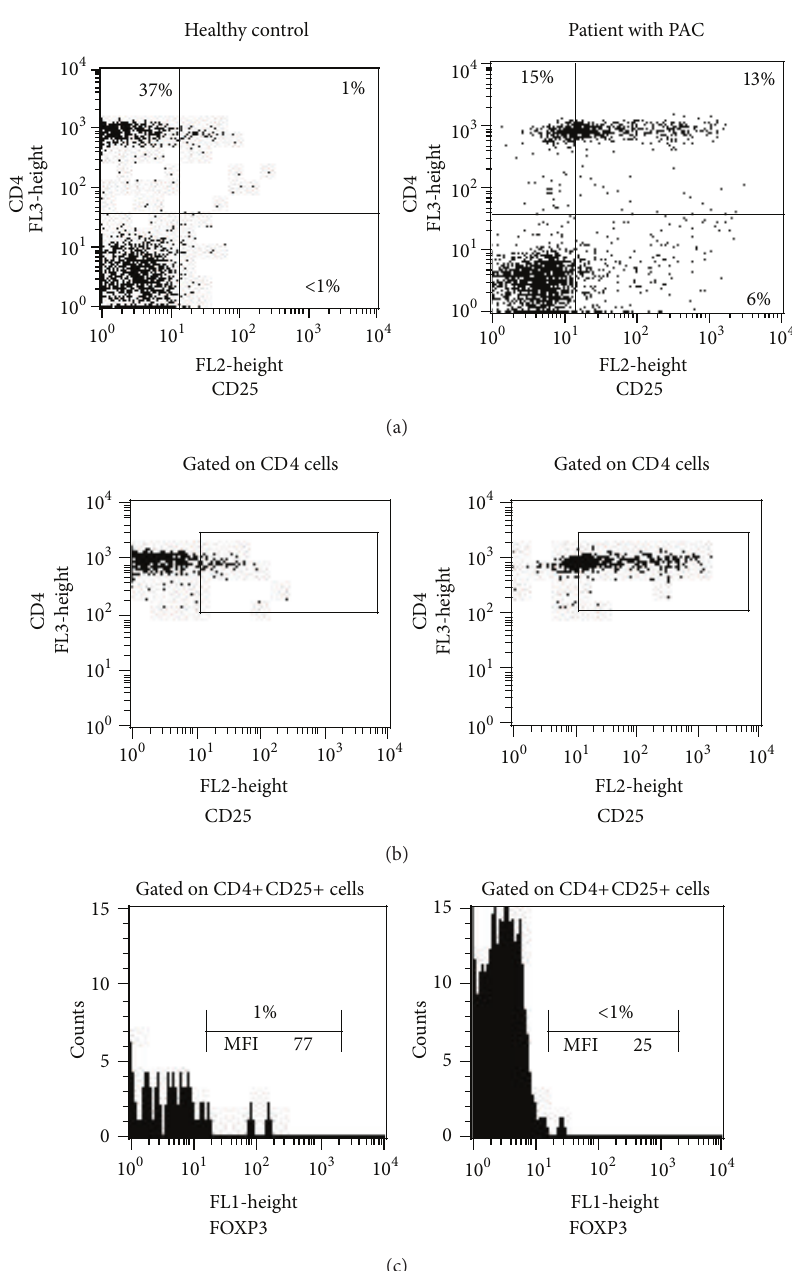
Figure 1: Frequency of CD25+ cells and CD4+CD25+FOXP3+ regulatory T cells in peripheral blood mononuclear cells. (a) Frequency of CD4+, CD25+, and double positive to CD4+CD25+ cells in PBMC from HC and PAC patient. (b) Same dot plot as (a); CD4+ cells gated as previously described in materials and methods, showing a gate performed to analyse CD4+CD25+ double positive cells. (c) Histogram from CD4+CD25+ gated cells (gated in (b)); the 𝑥 -axis denotes FOXP3 (MFI = mean fluorescence intensity). These dot plots and histograms are representative of 7 HC and 14 PAC